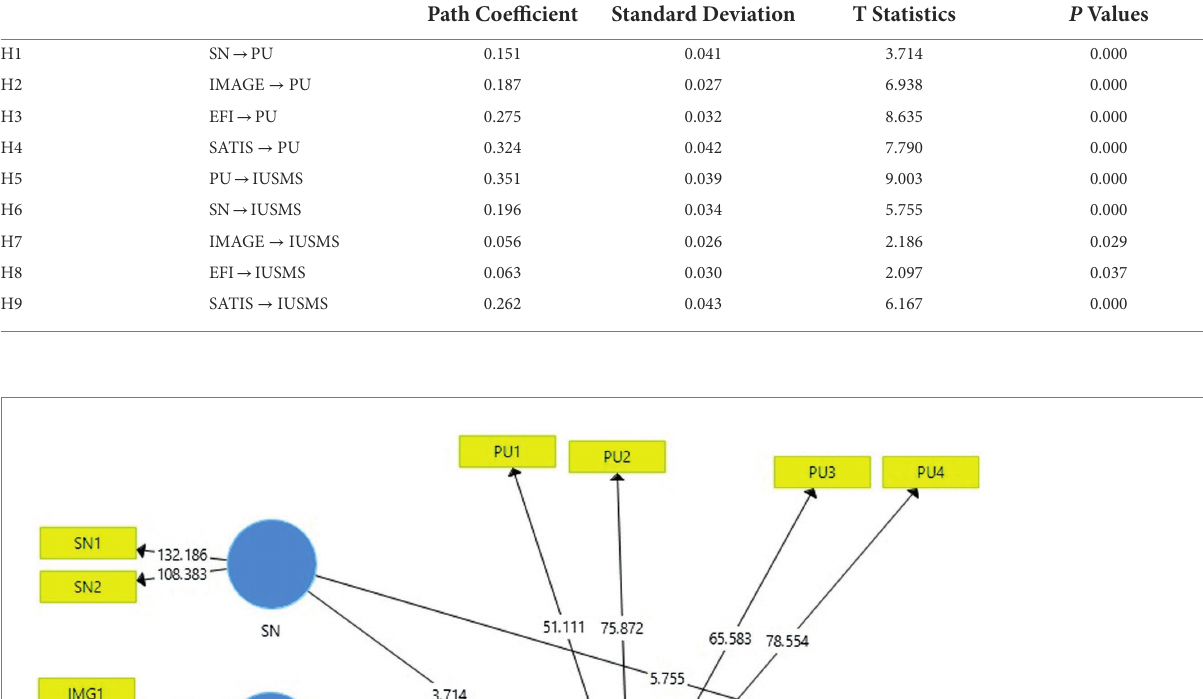
TABLE 5 Hypothesis